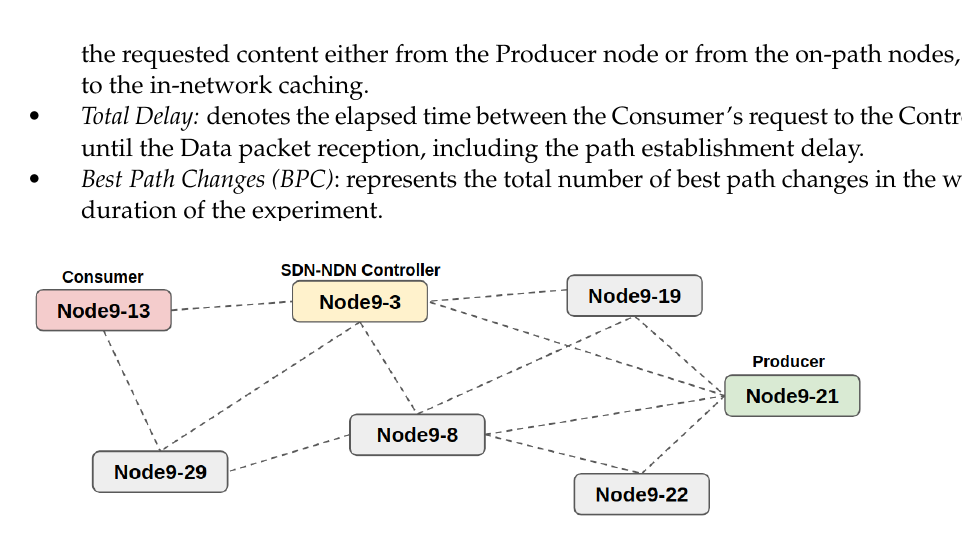
Figure 5. WMN topology, considering the 9th floor of the w-iLab.1 test.